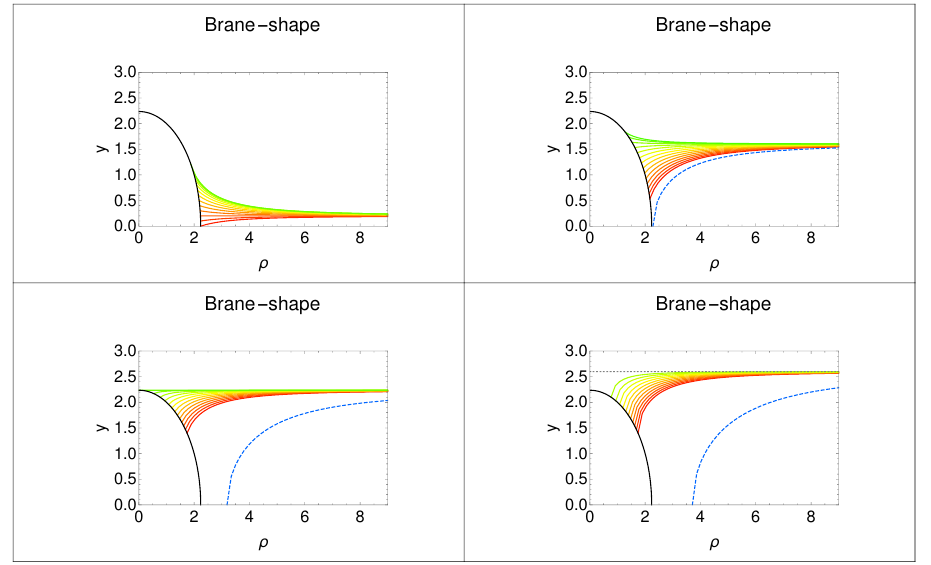
Figure 1 . D-branes embeddings in